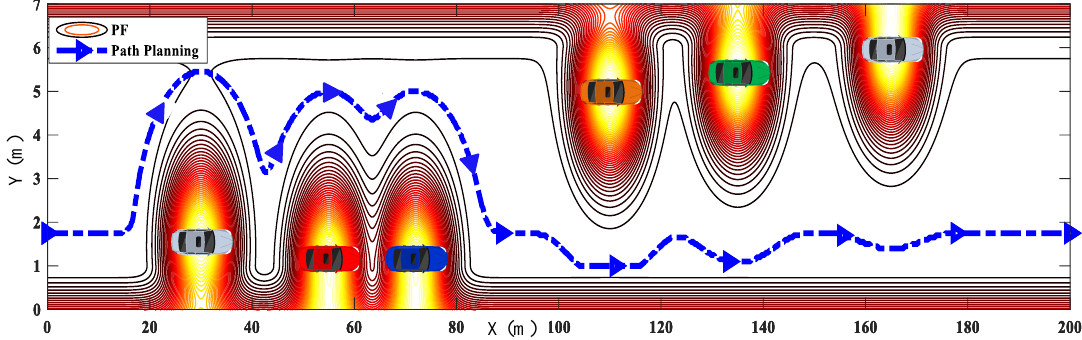
Figure 6. A driving scenario with